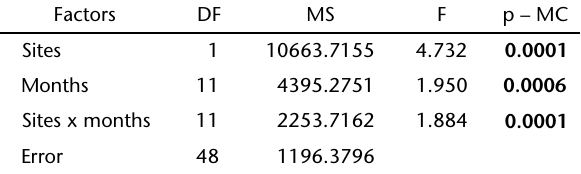
Table II. PERMANOVA applied to ichthyofaunal structure with respect to Sites, Months and the interaction between these factors. (DF) Degrees of Freedom, (MS) mean squares, (F) value of F in the test. Values of p-MC in bold indicate statistical significance (p < 0.05) obtained using the Monte Carlo permutation test.